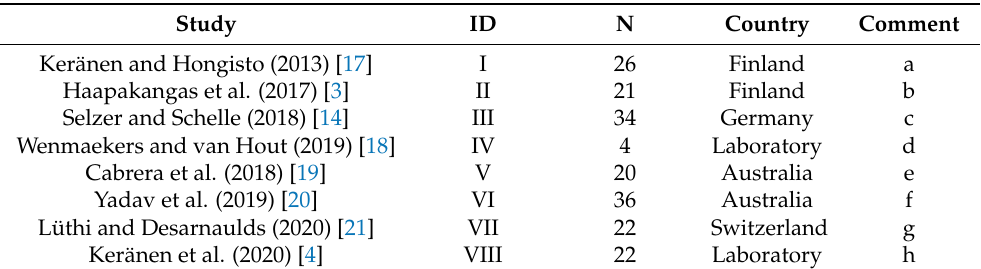
Table 2. Eight studies I–VIII reporting measurement data according to ISO 3382-3. N is the number of reported paths.